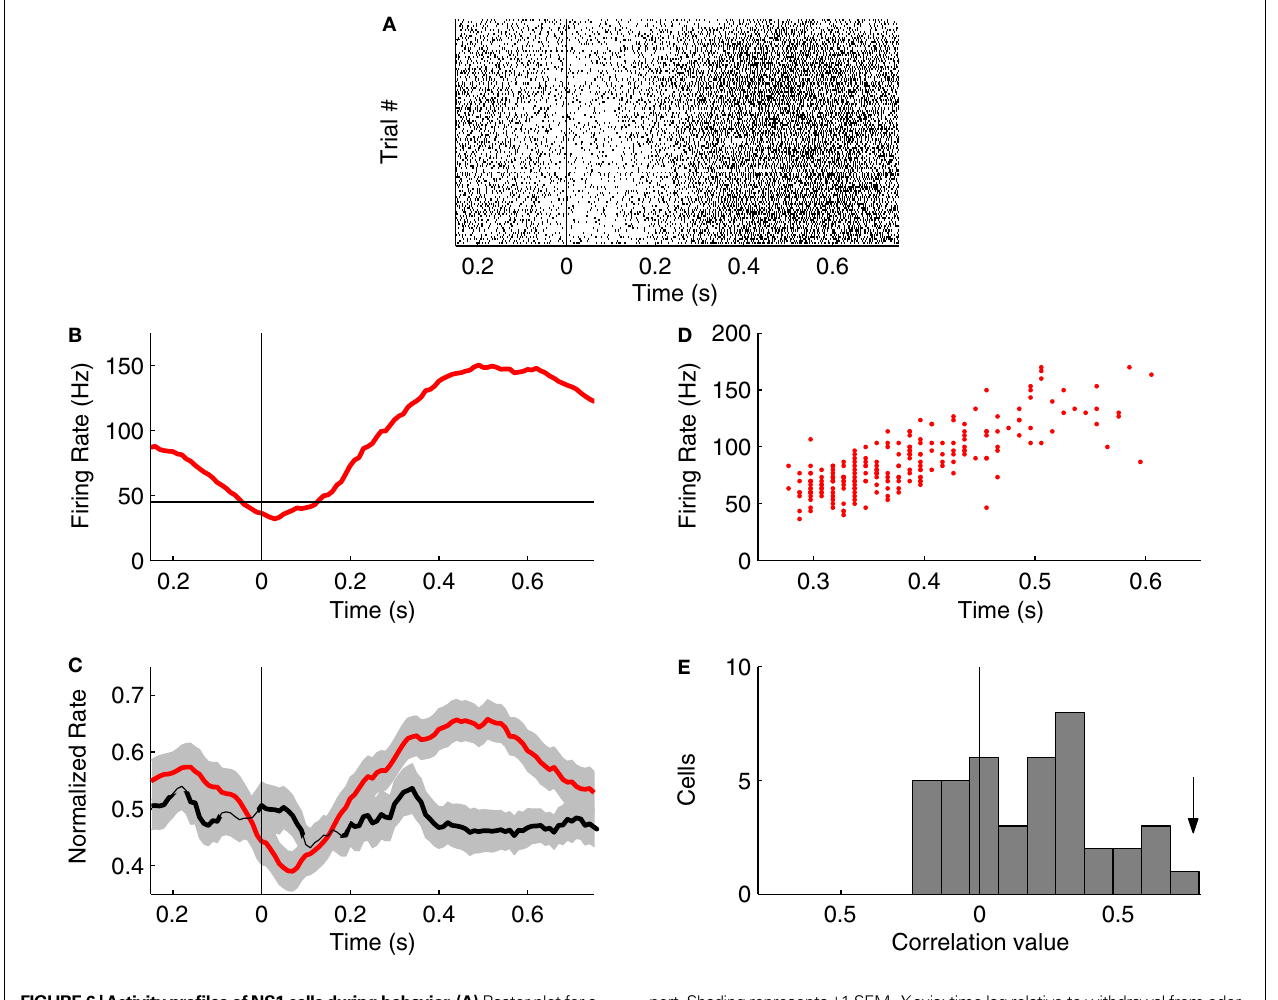
FIGURE 6 | Activity profi les of NS1 cells during behavior. (A) Raster plot for a single NS1 neuron time-locked to an animal’s exit from the odor port. Each line of dots corresponds to a single trial. (B) Post-stimulus time histogram (PSTH) for NS1 neuron in (A) , time-locked to an animal’s withdrawal from odor port. Red trace refl ects average fi ring rate across all trials for this cell; horizontal line indicates baseline-fi ring rate of cell. (C) Average peak-normalized PSTHs for populations of NS1 (red) and NS2 (black) neurons time-locked to animals’ withdrawal from odor